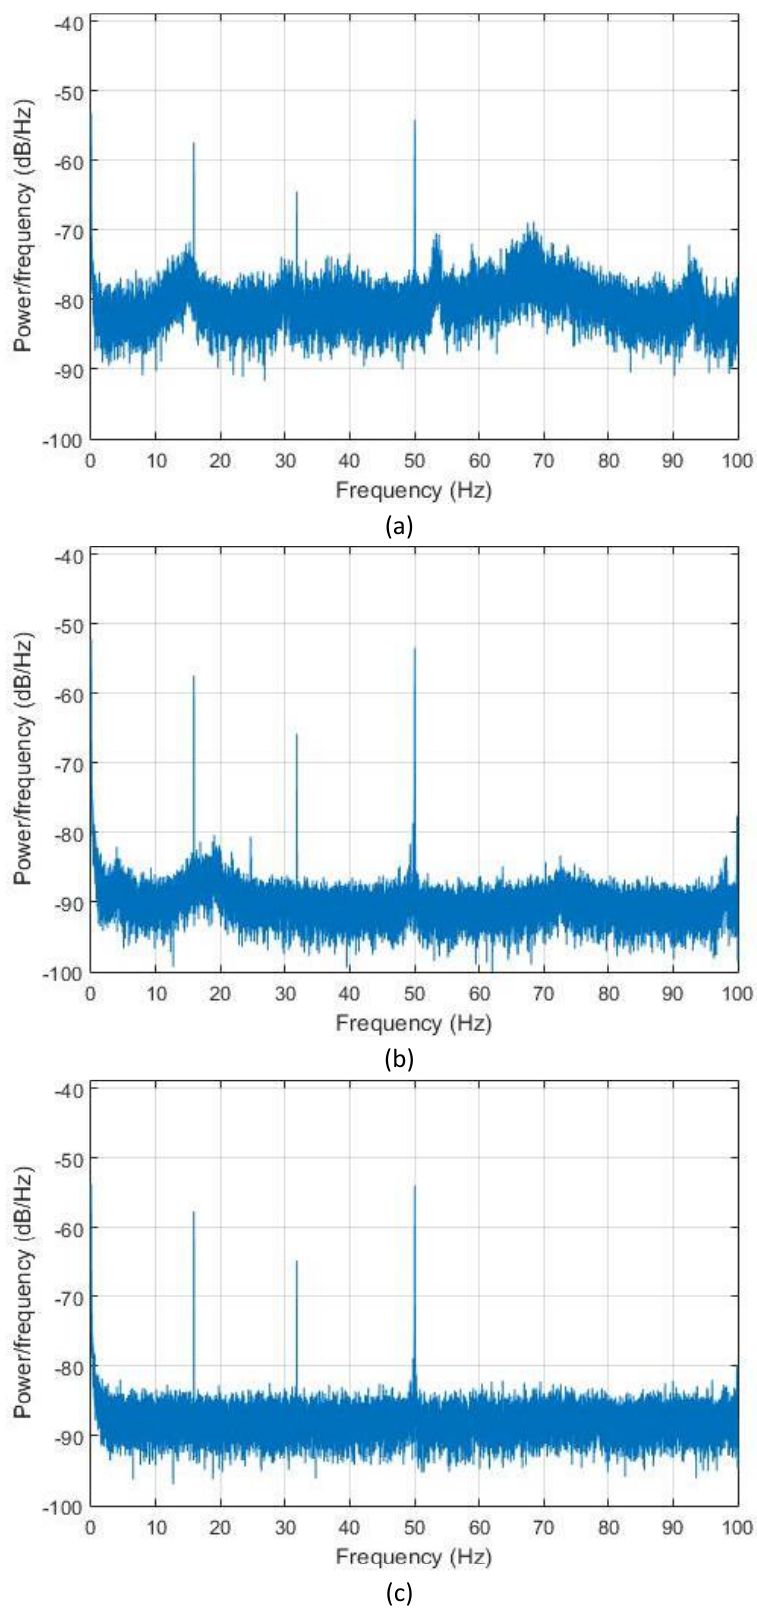
Figure 10. Estimated PSD of Sensor “B”. ( a ) Channel X. ( b ) Channel Y. ( c ) Channel Z.